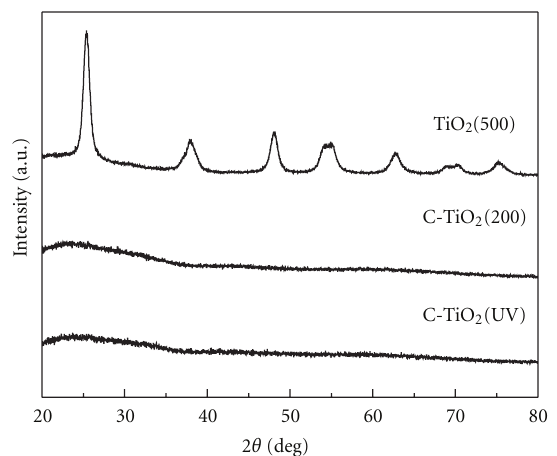
Figure 1: Powder XRD patterns of C-TiO 2 (UV), C-TiO 2 (200), and TiO 2 (500).